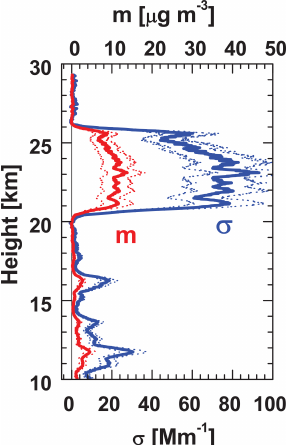
Figure 11. Smoke observation with lidar in the stratosphere over Punta Arenas on 29 January 2020 (see Fig. 1) in terms of the smoke extinction coefficient σ and particle mass concentration m . Extinction coefficients were obtained by multiplying the respective backscatter coefficients with a lidar ratio of 95sr. The errors mar- gins (thin dotted) indicate relative uncertainties as given in Table 4 for the Raman lidar option in the case of aged